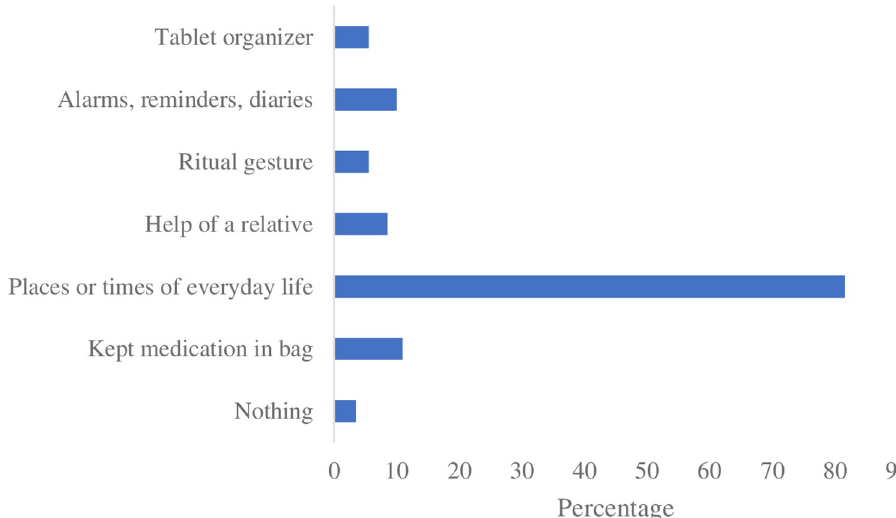
Fig 2. Strategies adopted by the participants to remember taking their